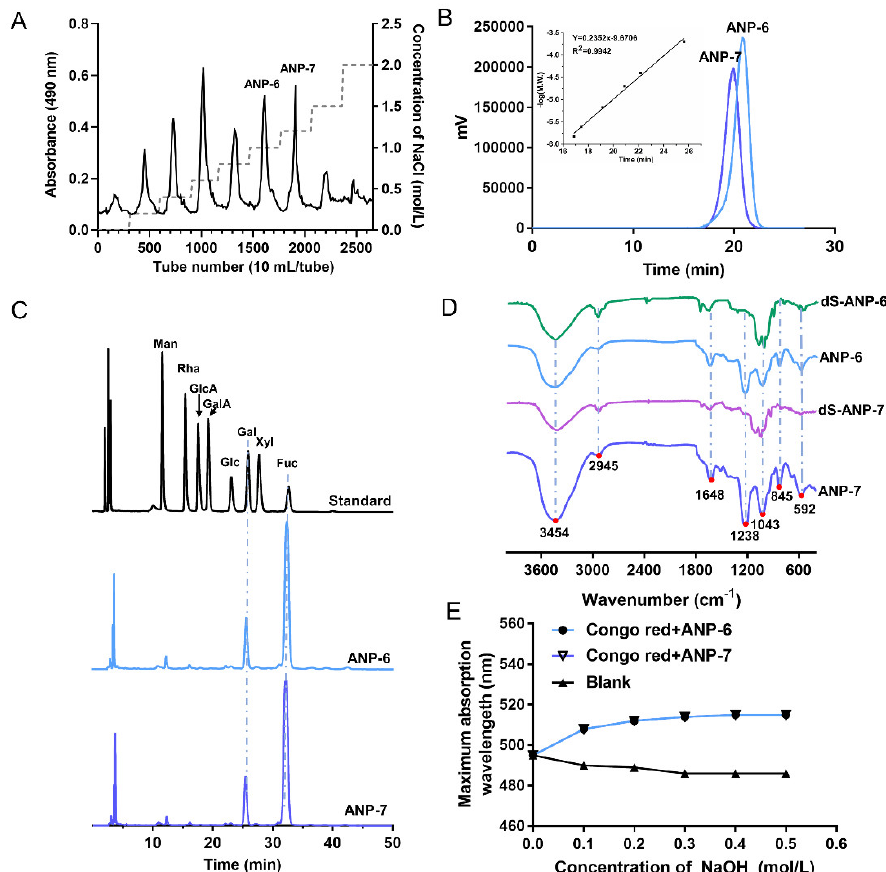
Figure 1. Chemical characteristics of the fucoidan from A. nodosum . Stepwise elution curve of the crude ANP on a DEAE−52 column ( A ), HPGPC profiles of ANP-6 and ANP-7 ( B ), FT−IR spectra of ANP-6, dS-ANP-6, ANP-7, and dS-ANP-7 ( C ), HPLC profiles of monosaccharide standards, ANP-6, and ANP-7 ( D ), and the Congo red experiment of ANP-6 and ANP-7 ( E ).